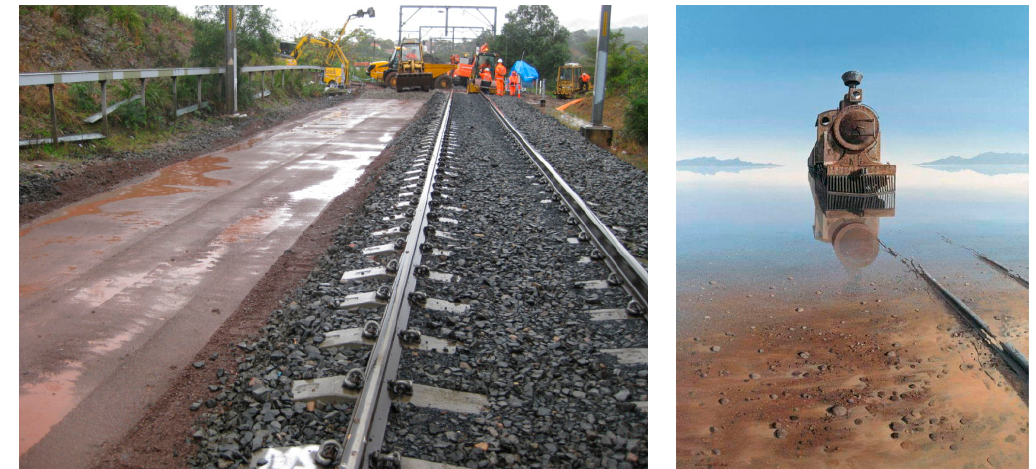
Figure 1. A typical ballasted track (left). The capping layer called ‘sub-ballast’ is prepared by compacting roller prior to laying ballast. In reality, the capping layer and subgrade are non-homogenous and cannot be accurately modelled by a simple constant elastic half-space nor a continuous layer. These layers are thus designed under higher safety margin or higher factor of safety by the allowable stress design concept [16,17]. The design takes into account the accumulated strains of these layers, which are often limited over a target design period (e.g., 15–25 years). Track maintenance cost function of deteriorated ballasted tracks will increase over time. The right figure shows a train standing in a flooded